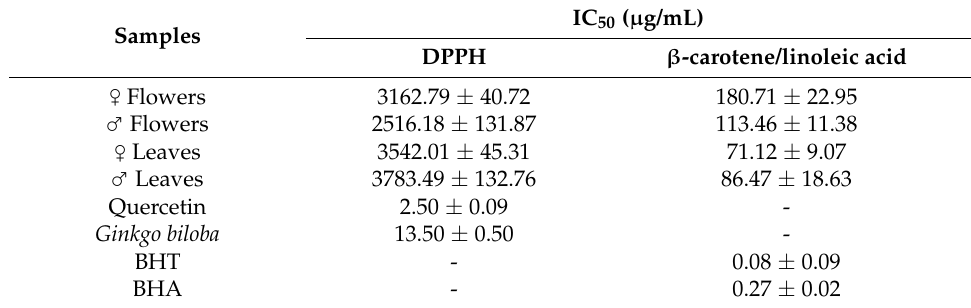
Table 3. Antioxidant activities (IC 50 , mean ± SD) by DPPH free radical scavenging and β -carotene/linoleic acid methods of the essential oils from flowers and leaves of H. brasiliense .